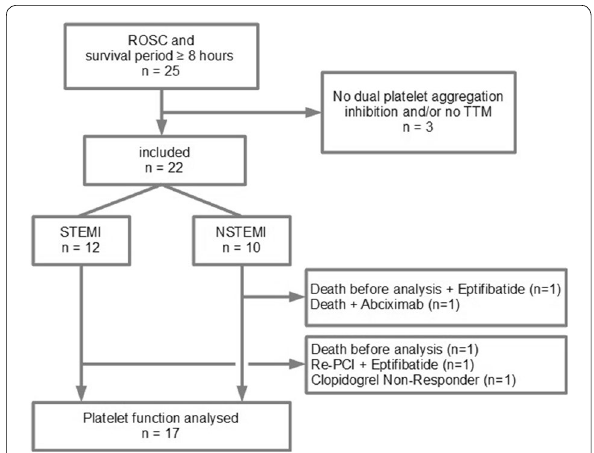
Fig. 1 Flow diagram of inclusions and exclusions for patients with return of spontaneous